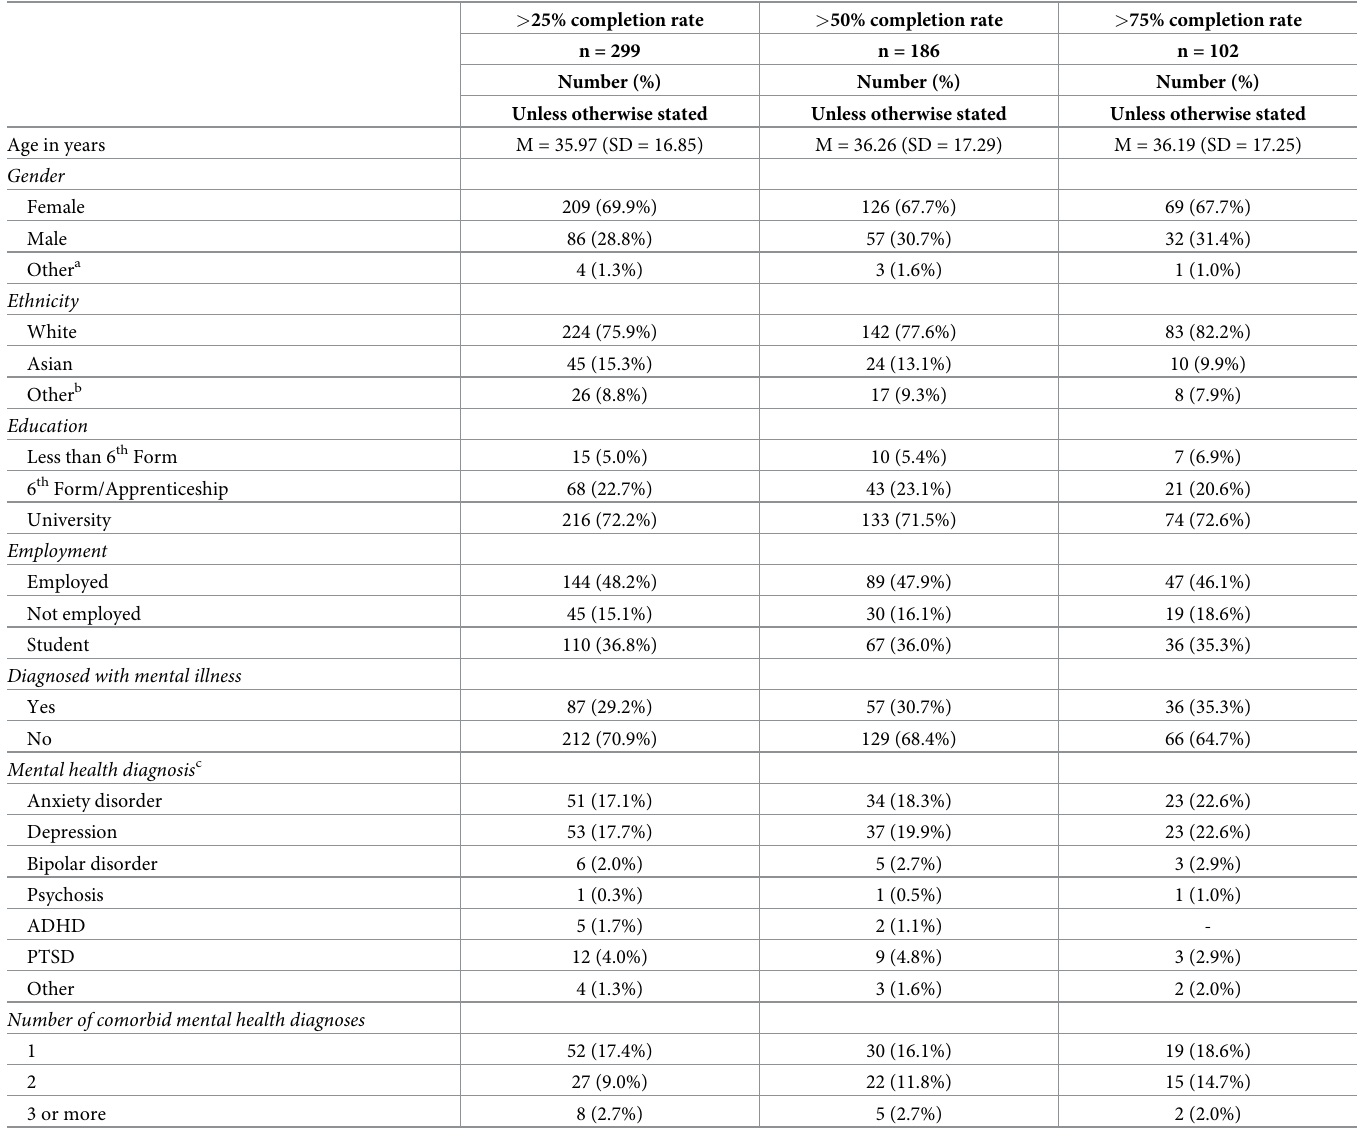
Table 1. Demographic characteristics of